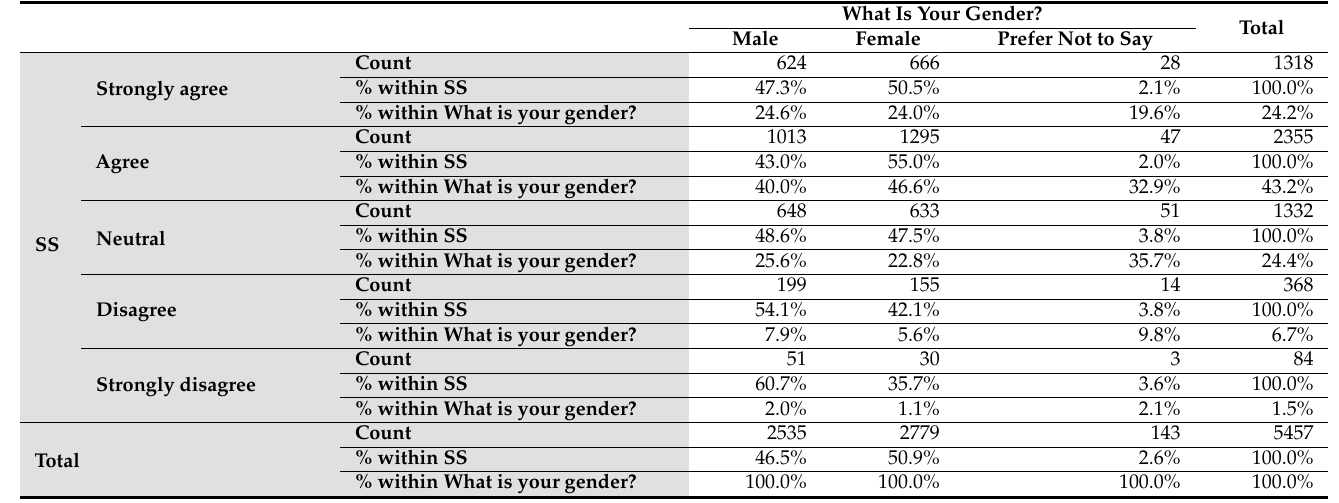
Table 12. Symbolic societal value of EVs and respondents’ gender cross-tabulation.